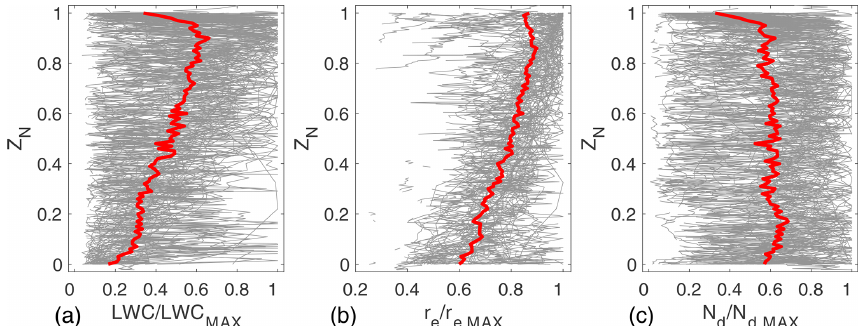
Figure 3. CDP profiles normalized by their maximum value from the three NAAMES campaign: (a) of liquid water content, (b) r e , and (c) cloud droplet number concentration N d x . Normalized height ( Z N ) corresponds to 0.0 for cloud base and 1.0 for cloud-top height. Individual and mean profiles are depicted in gray and red,